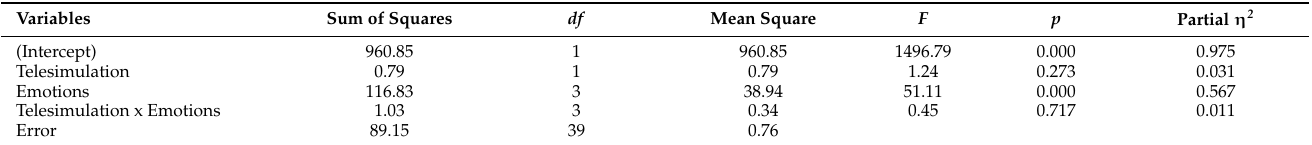
Table 4. ANOVA results of emotions after the